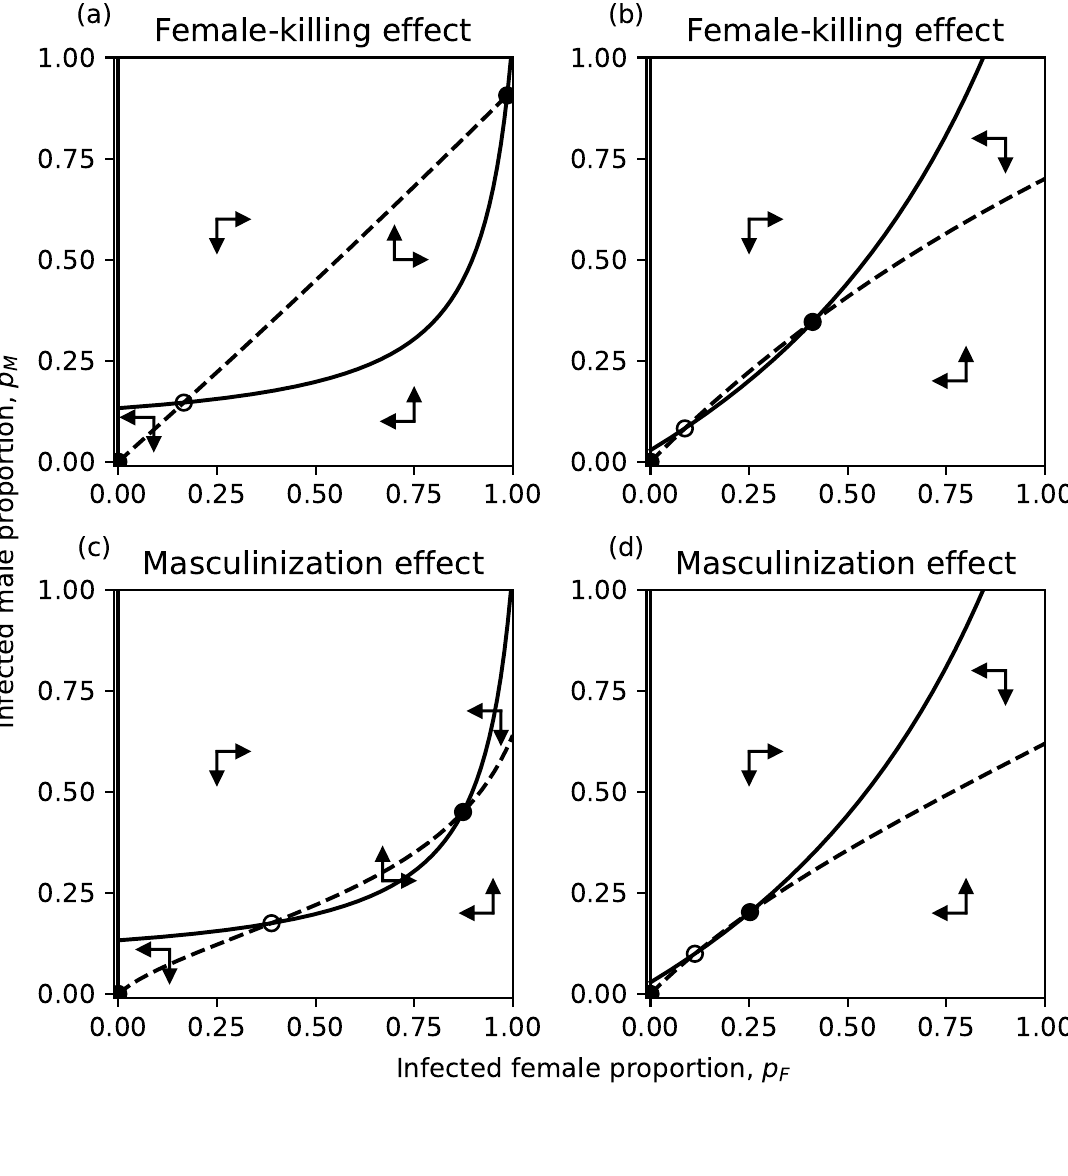
Figure 5. Equilibria of the two haplodiploid models in ( p F , p M ) -space. In left column f < 1 , right f > 1 . Dot: stable equilibria, circle: unstable equilibrium. Dashed line: male null-cline ( ∆ p M = 0 ), solid line: female null-cline ( ∆ p F = 0 ). a) The stable equilibrium is close to fixation and invasion threshold exists. b) Low frequency stable equilibrium with invasion threshold. c) The non-trivial stable equilibrium at ˆ p M < 1 / 2 , although f < 1 . d) Low frequency stable equilibrium with invasion threshold. Parameters: a) and c) f = 0 . 95